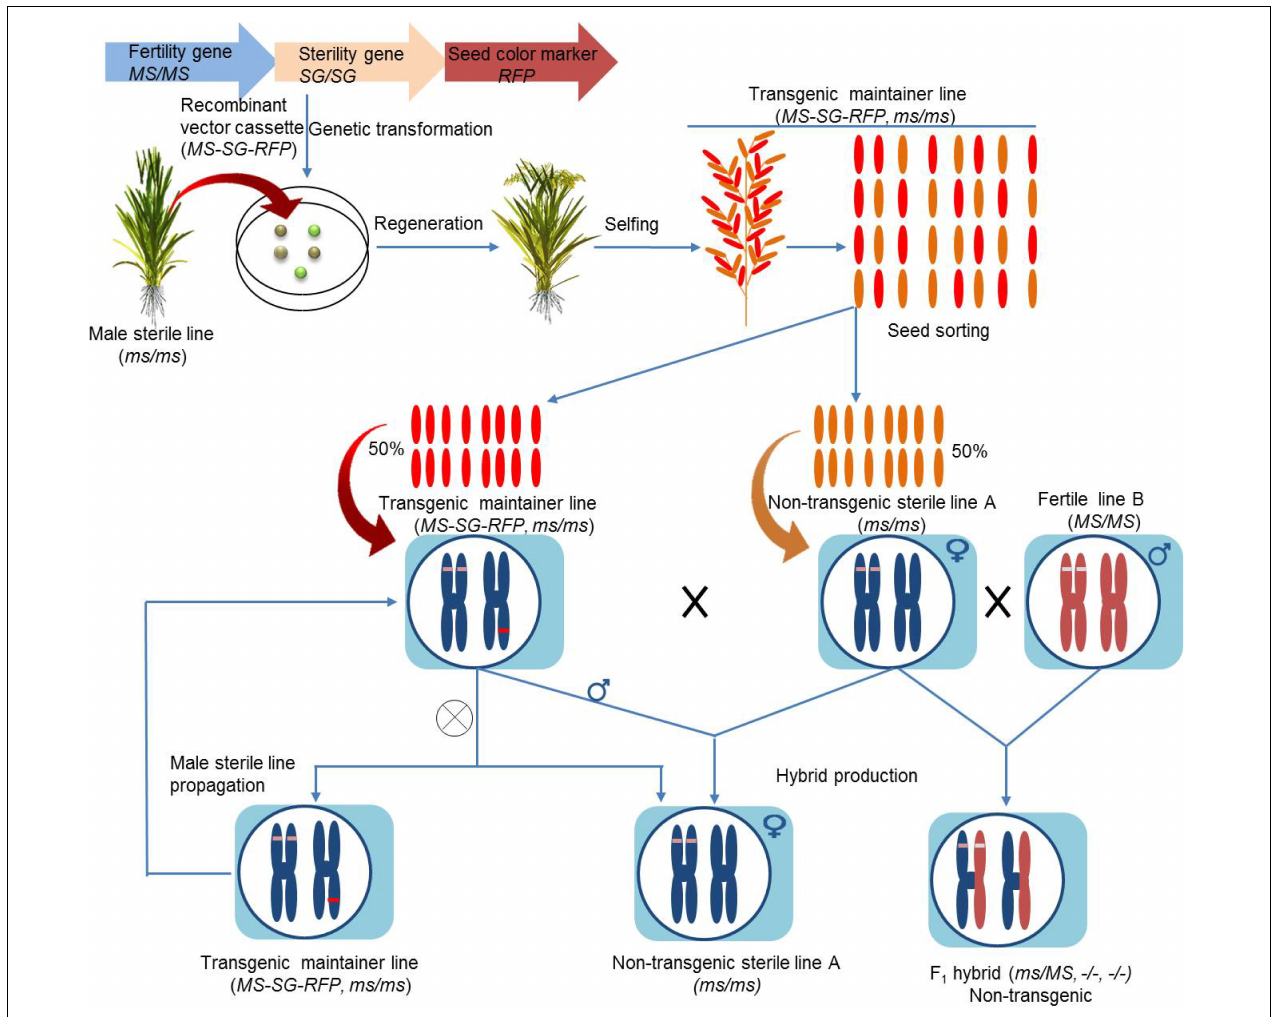
FIGURE 5 | Illustration of seed production technology (SPT) using transgenic construct-driven non-transgenic hybrid strategy in